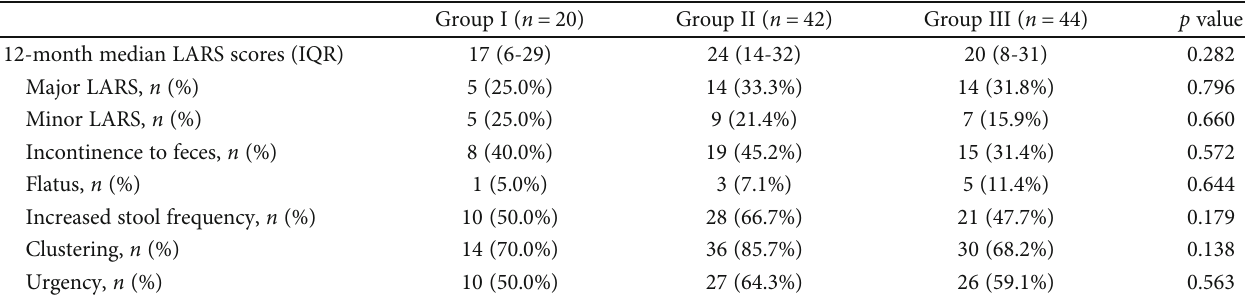
Table 4: Details of LARS at follow-up 12 months after index